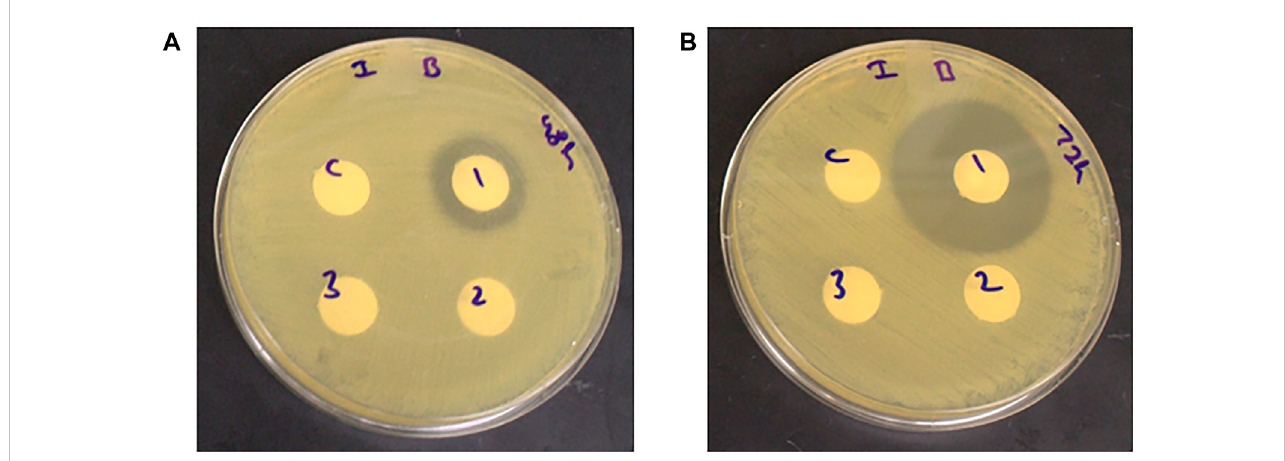
FIGURE 4 Antimicrobial activity of unfermented and L. plantarum fermented (with and without pH adjustment) corn-DDGS extracts against H. pylori at (A) 48-and (B) 72-h fermentation time points. C- control (sterile water), one- unfermented extract, 2-fermented extract (adjusted pH), and three- fermented extract (unadjusted pH). Zone of inhibition measured in millimeters (mm).